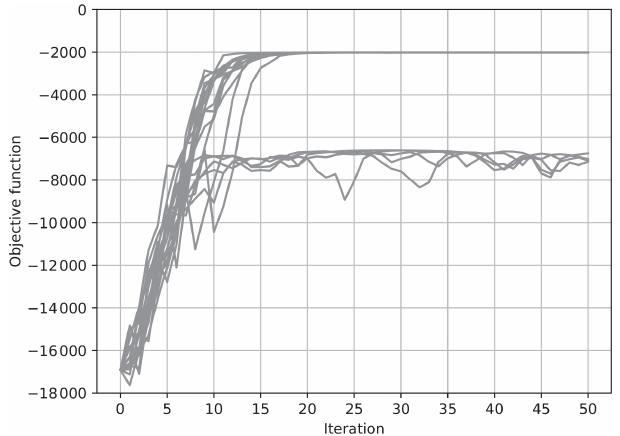
Figure 7. The value of the objective function J for each iteration for 20 trials of the estimation. The ensemble was updated using Eq. (36) with δ = 1 . 5 × 10 − 3 , and the ensemble window was taken as 0 < t ≤ 10.